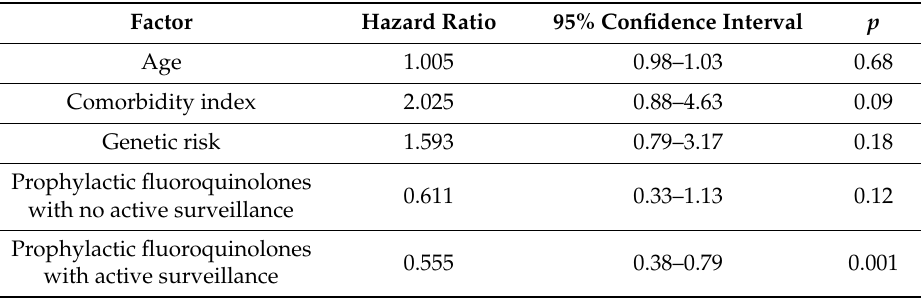
Table 5. Multivariate analysis of factors related to survival. Prophylactic fluoroquinolones and active surveillance were introduced in the model as an